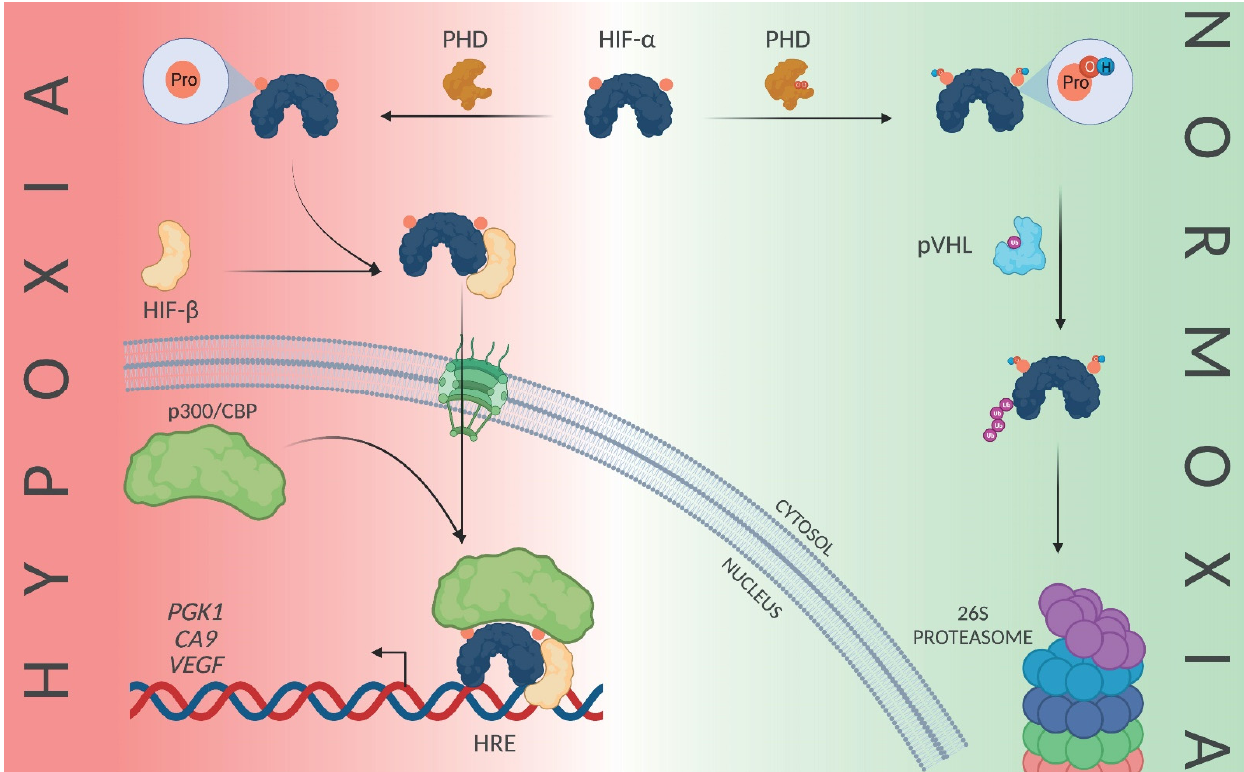
Figure 2. Schematic overview of the hypoxia signaling. In the absence of oxygen, prolyl hydroxylases (PHD) fail to hydroxylate the alpha subunits of the hypoxia-inducible factors (HIF), which leads to HIF dimerization in the cytosol, thus resulting in the formation of the transcriptionally active HIF and the adaptive gene expression changes. In the presence of oxygen, HIF undergoes prolyl-hydroxylation by PHD, which is followed by ubiquitination by von Hippel–Lindau protein, ultimately leading to its proteosomal degradation. Abbreviations used are: PHD: prolyl hydroxylases; HIF: hypoxia-inducible factor; pVHL: von Hippel–Lindau protein; HRE: hypoxia response element. Figure was created using BioRender.com.